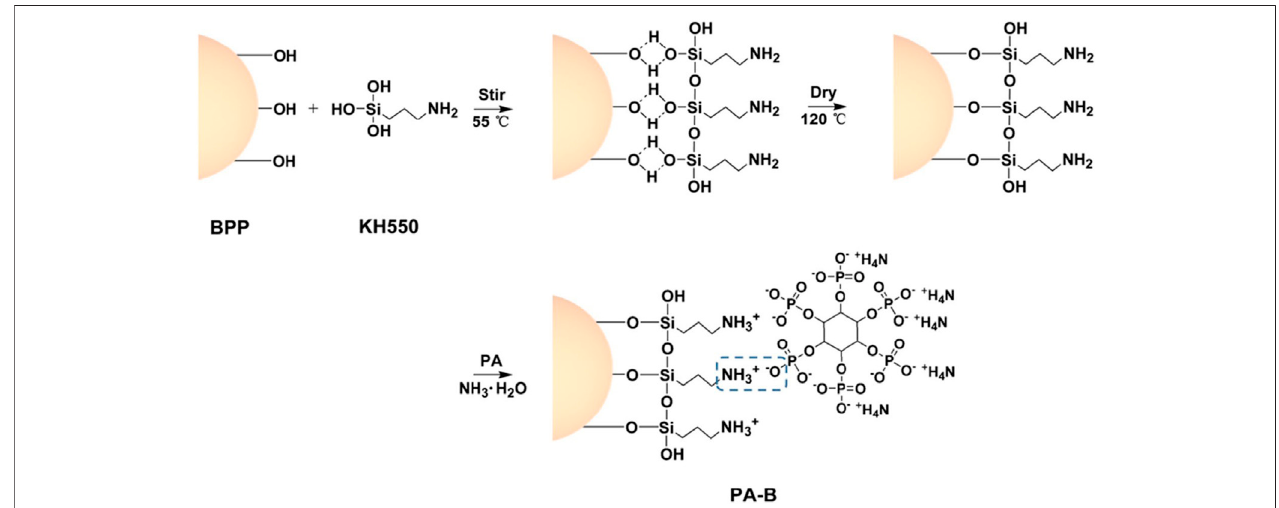
FIGURE 8 | The fabrication of PA-B (Kong et al.,